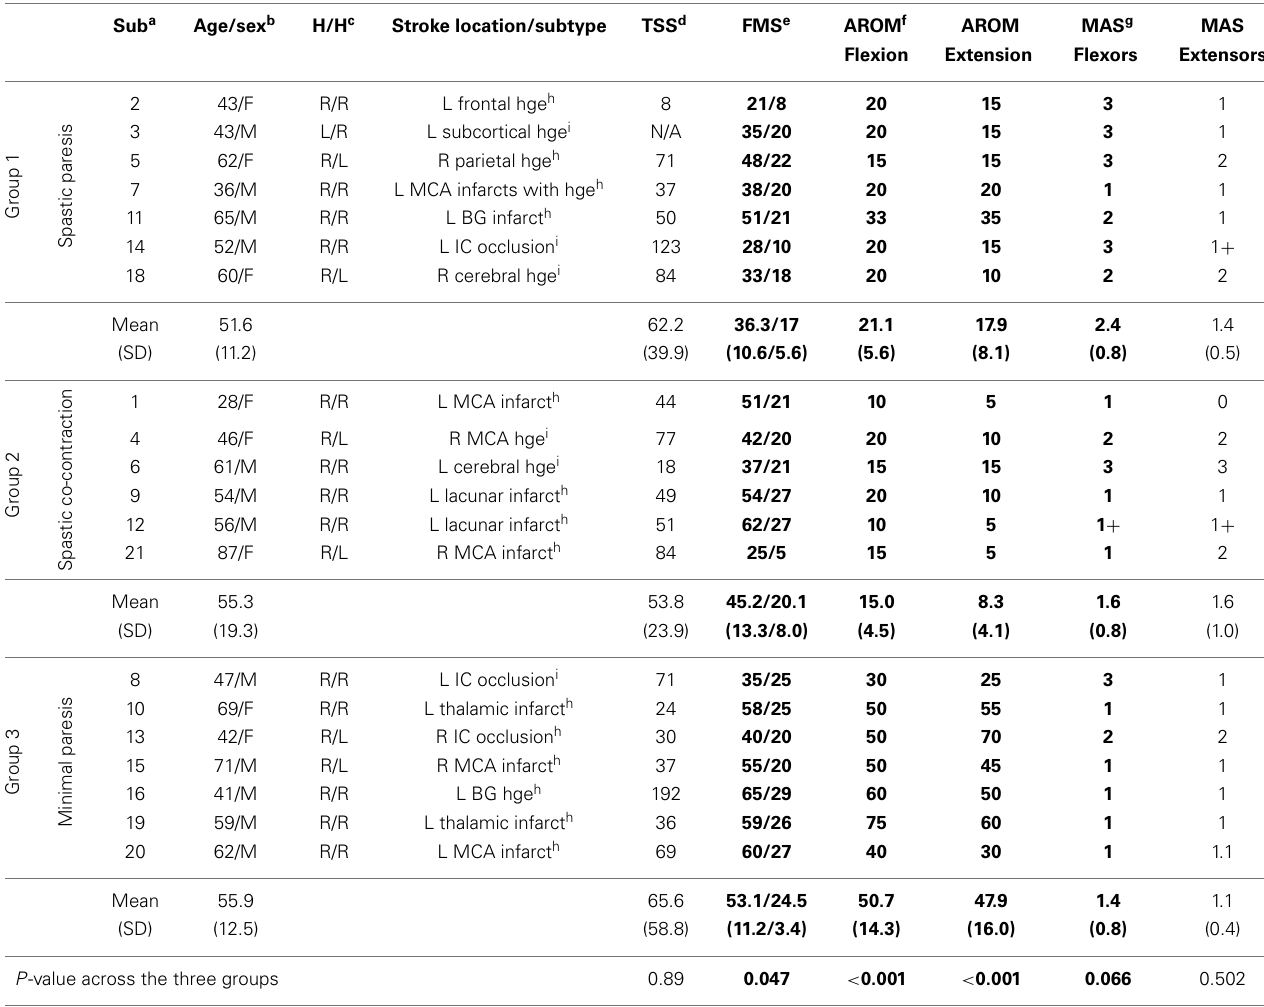
Table 1 | Clinical characteristics of subjects: a Sub, subjects in each group (see also Figure 2); b age, in years; c H/H, handedness/hemiparesis; d TSS, time since stroke in months; e FMS, Fugl-Meyer score, values represent total upper extremity scores out of a maximum of 66/hand and wrist score out of a maximum of 30; f AROM, active range-of-motion in degrees at the wrist measured with a goniometer; g MAS, modifiedAshworth Scale measured at the wrist. Lesion location and stroke subtype obtained from: h radiology reports and i medical history narrative from subject